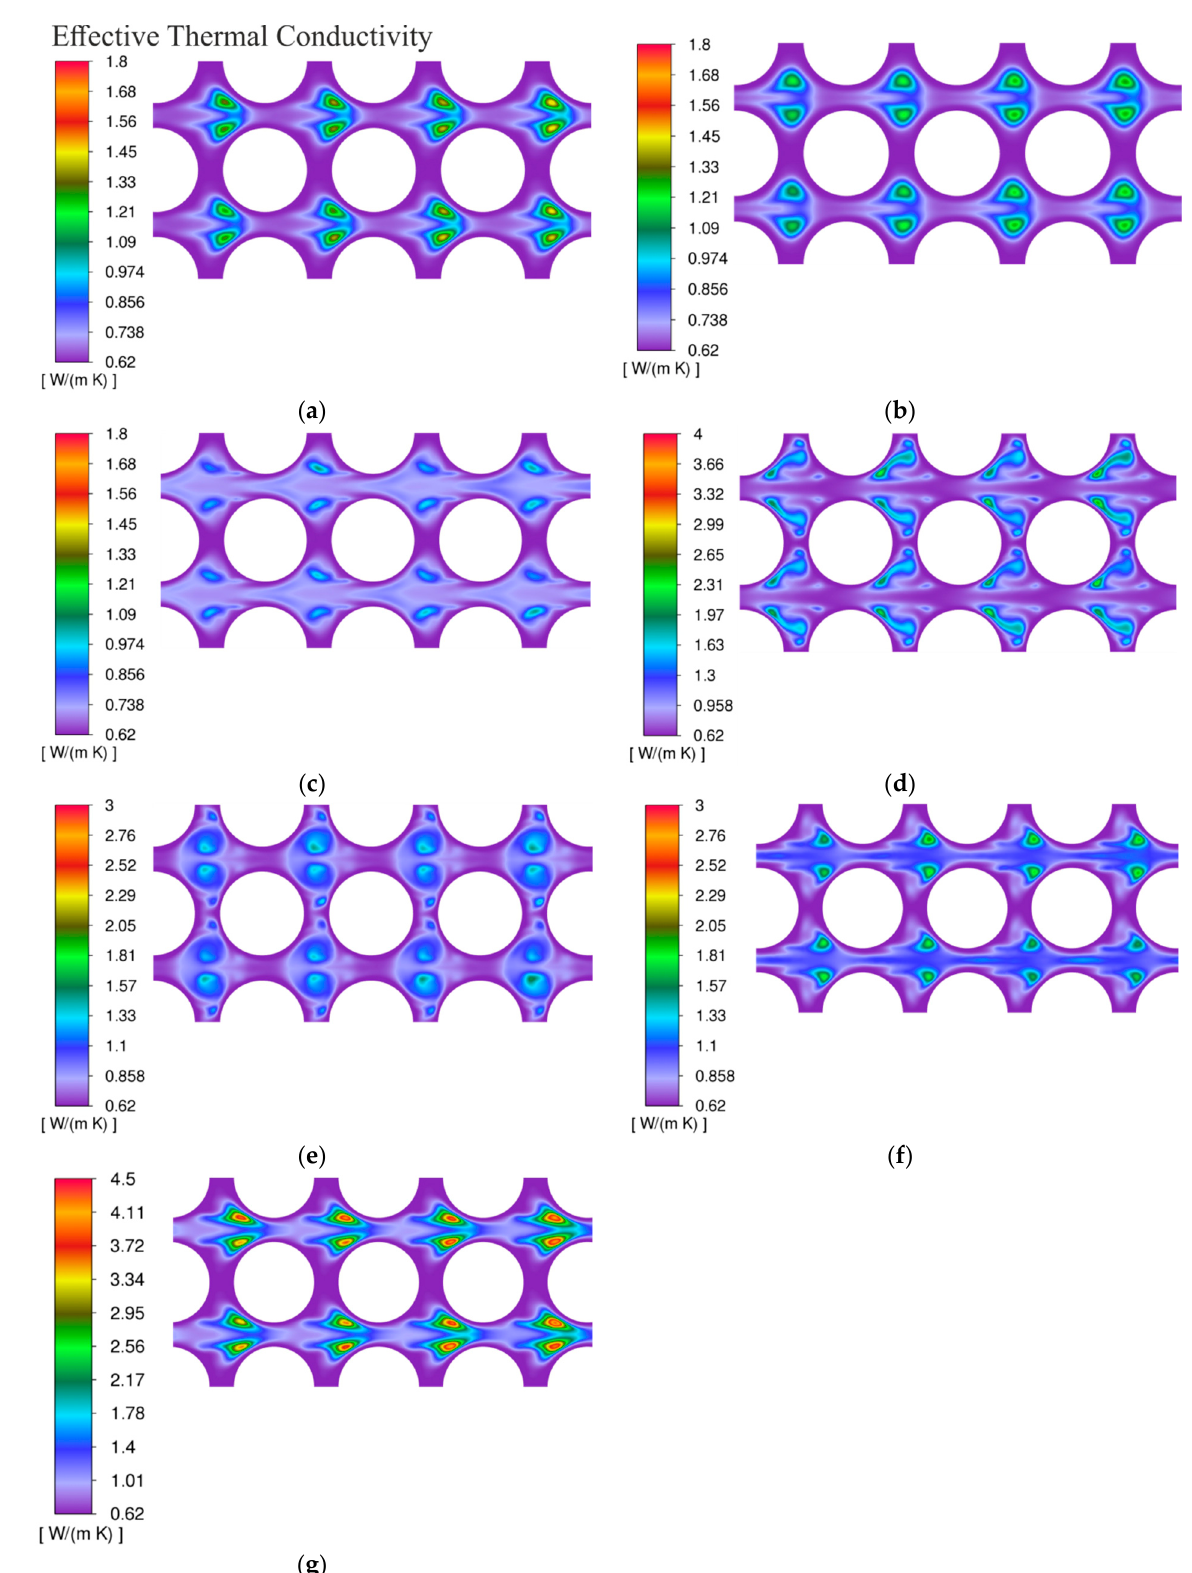
Figure 19. The instantaneous effective thermal conductivity contour plots at different phases of pulsations for the three central rows of the tube bundle at A / D = 3, f = 0.5 Hz: ( a ) τ / T = 0.005 ( b ) τ / T = 0.025; ( c ) τ / T = 0.07; ( d ) τ / T = 0.125; ( e ) τ / T = 0.185; ( f ) τ / T = 0.32; ( g ) τ / T =